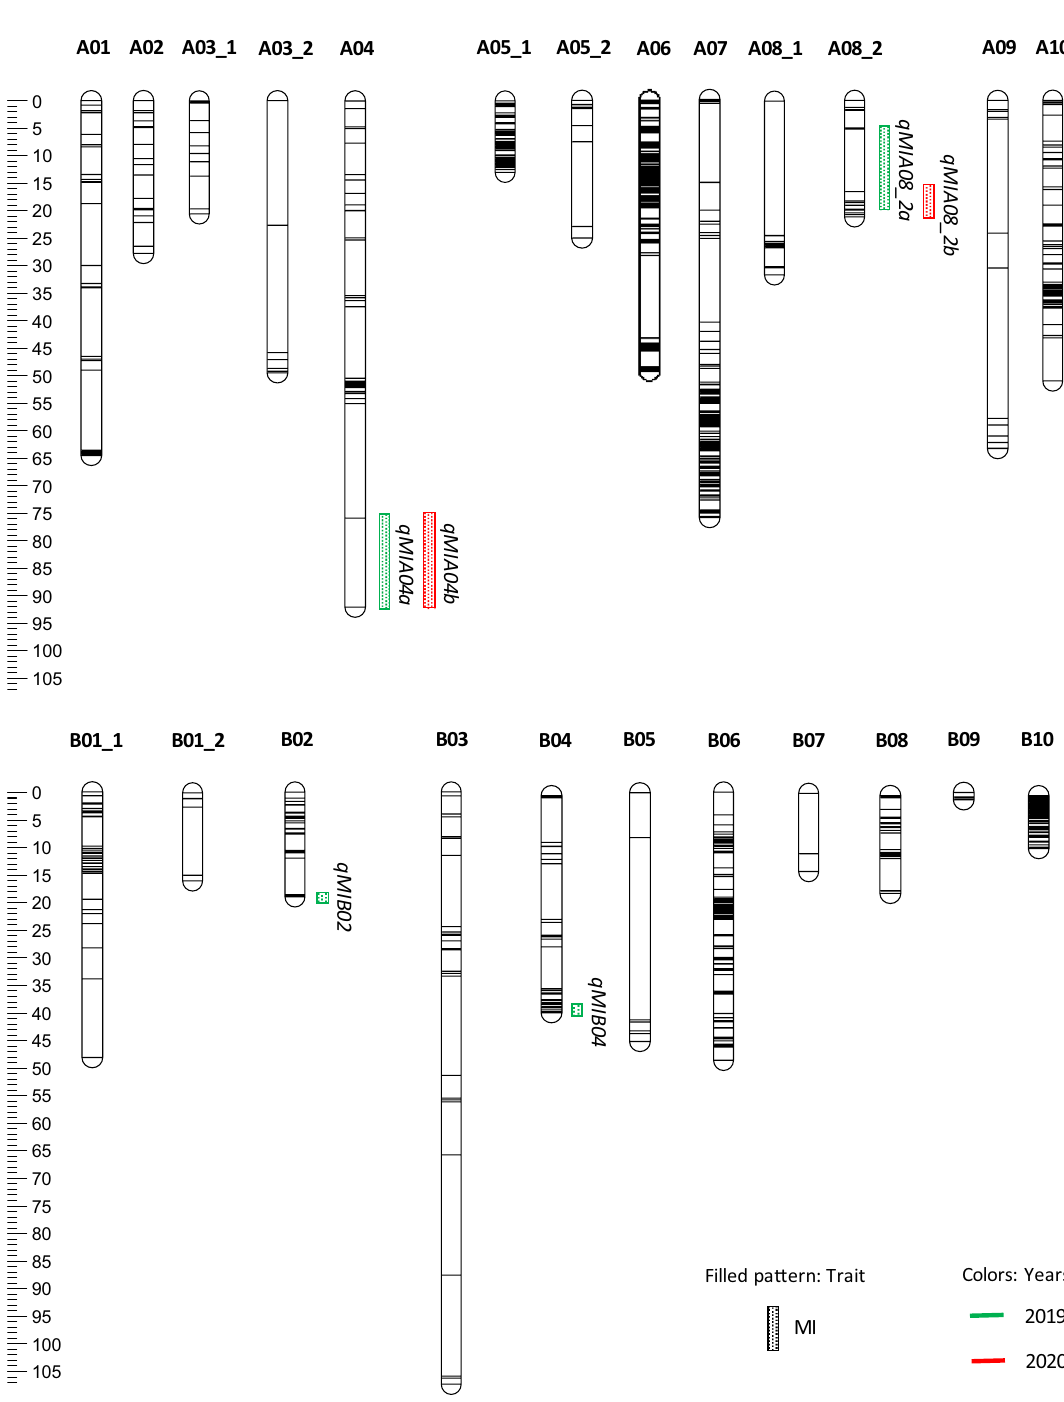
Figure 3. An overview of the genetic map and the QTLs identified for MI trait in 2 years. MI, maturity